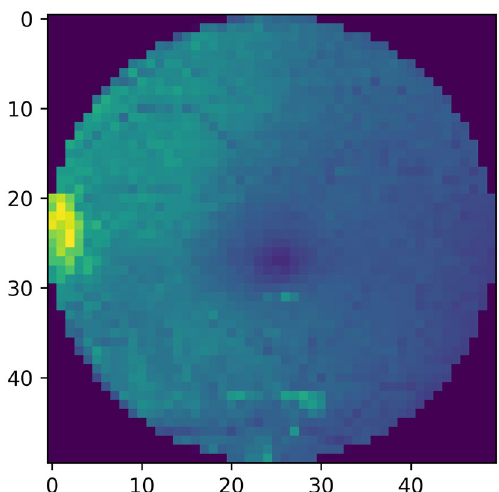
Figure 3. Image size (50 × 50).